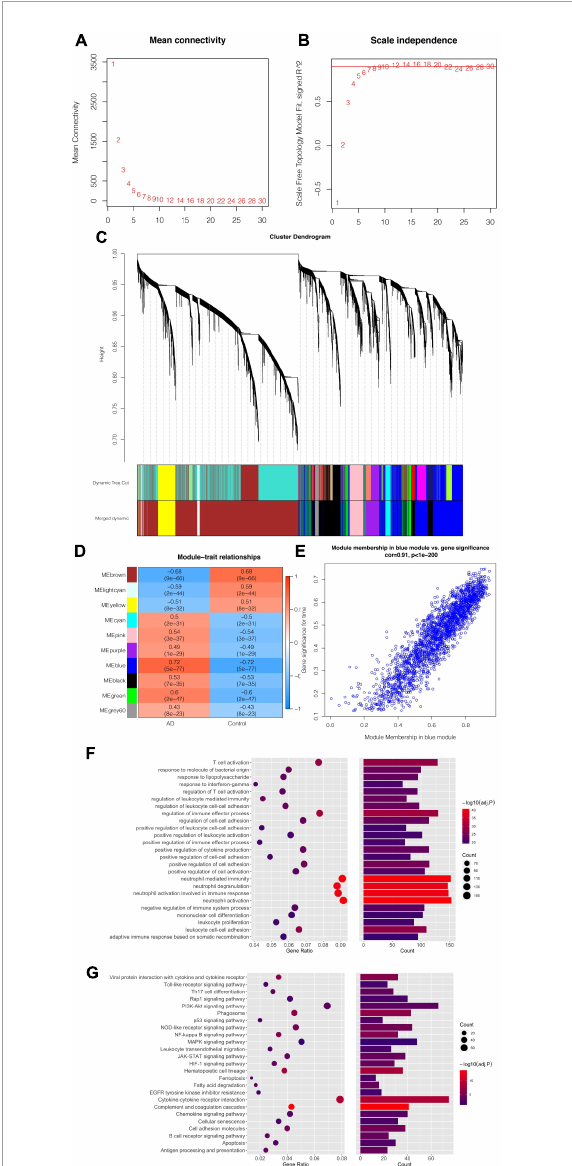
FIGURE4 Weighted correlation network analysis of DEGs and Enrichment analysis result for the identified module. (A,B) Analysis of the scale independence and the mean connectivity for various soft-threshold powers. (C) The cluster dendrogram of 10,044 DEGs, with 10 modules in different colors. (D) Heatmap of the correlation between modules and phenotypes. Red shows a positive correlation and blue shows a negative correlation. Each cell contains the correlation coefficients. (E) A scatterplot of Gene Significance (GS) vs. Module Membership (MM) in the blue. Hub genes are evaluated by GS > 0.7 and MM > 0.8. (F) Gene Ontology enrichment analysis. (G) Kyoto Encyclopedia of Genes and Genomes enrichment